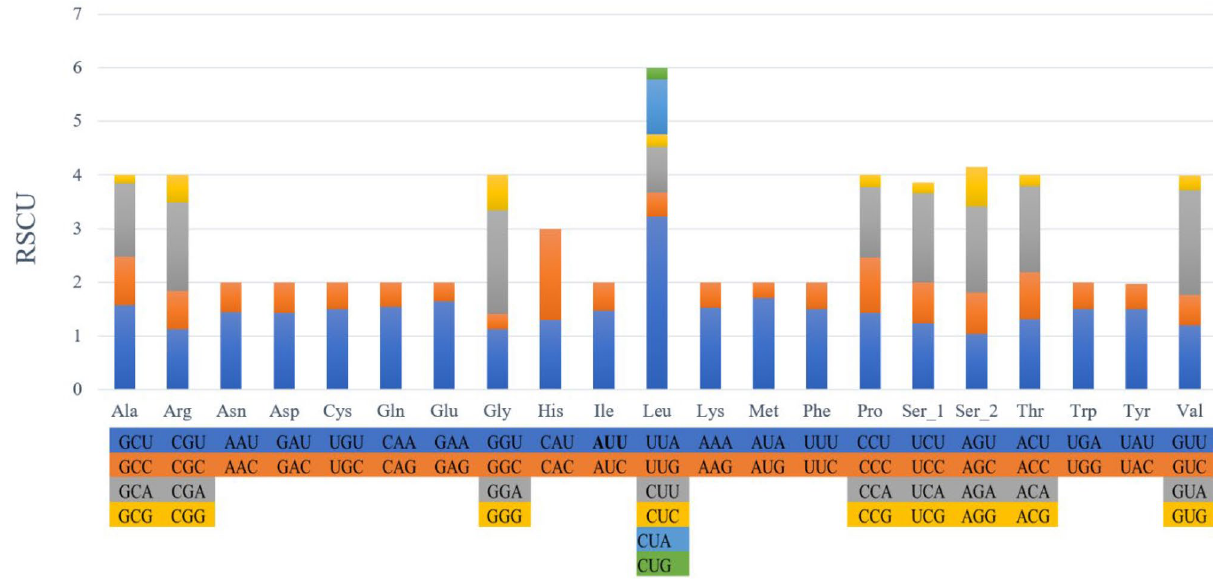
Figure 2. Relative synonymous codon